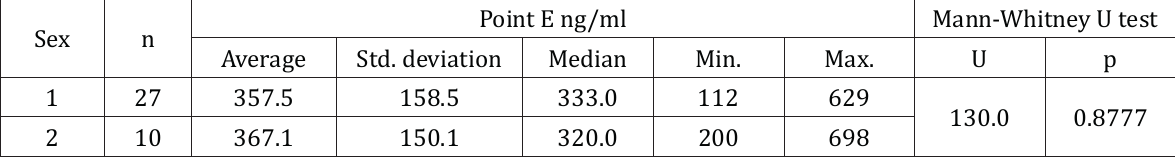
Table 12. Descriptive statistics – The concentration of MMP-9 at the end of the study in both men and women and the results of a Mann- Whitney U test